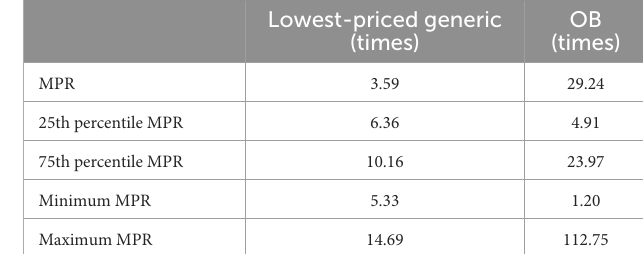
TABLE 4 Prices in the private sector compared to international reference